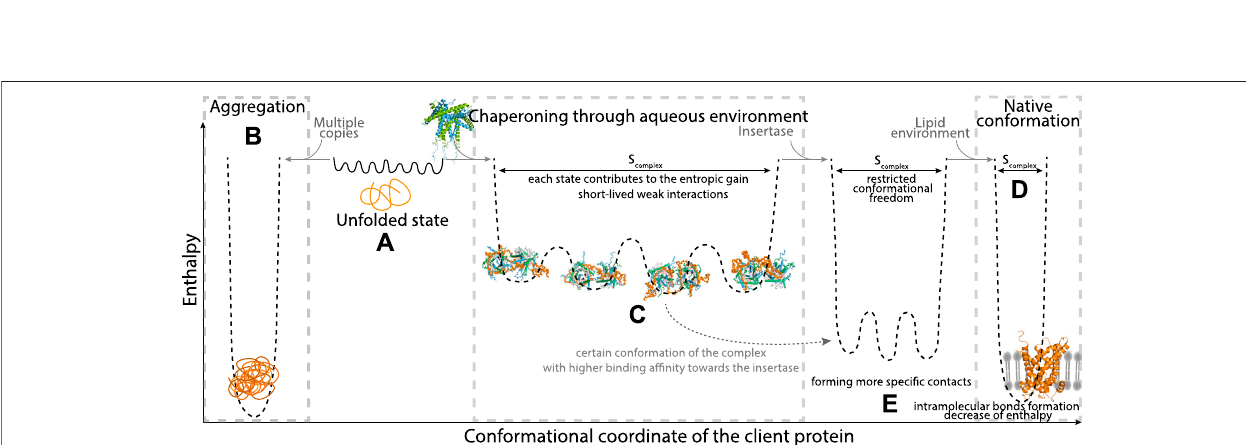
Frontiers in Molecular Biosciences |